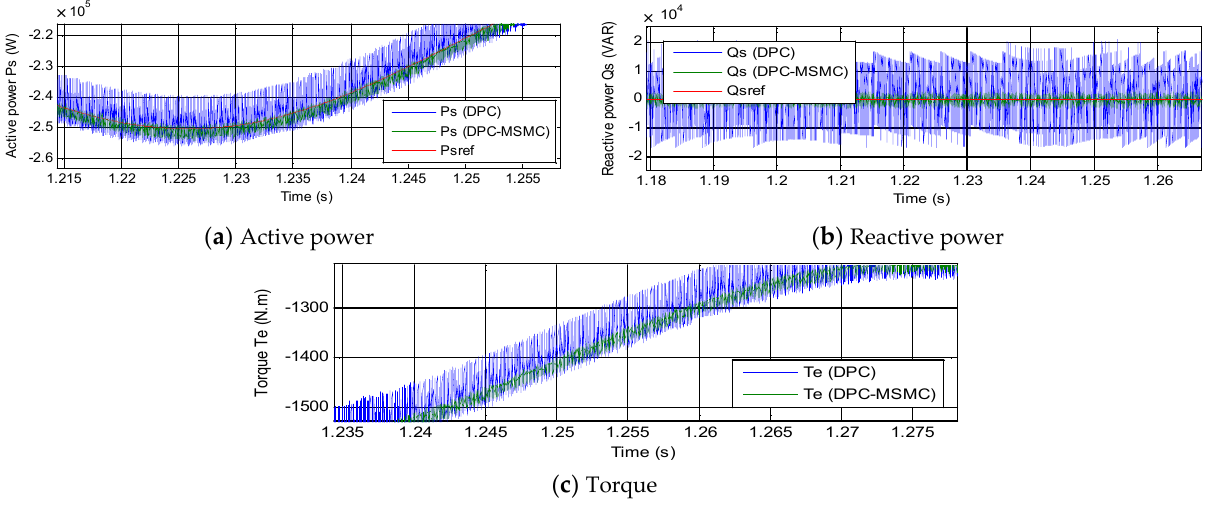
Figure 12. Zoom in the reactive power, torque, active power and current (robustness test). Table 6. Comparison of ripple values between the designed and the conventional DPC strategy (robustness test).